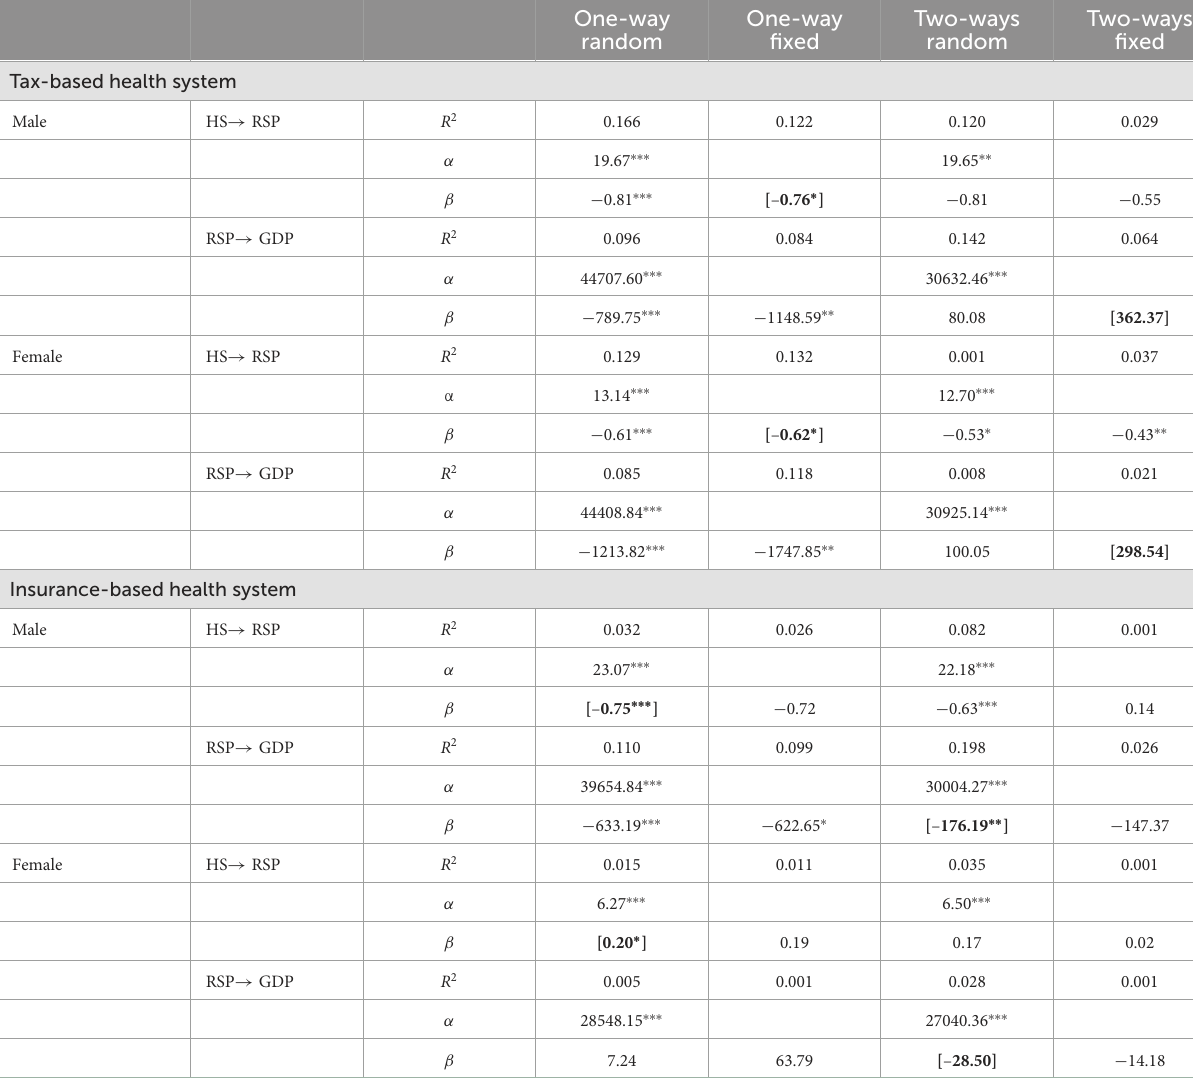
TABLE 3 Panel regression analysis—relationships between economic and treatable mortality indicators classified by gender and health